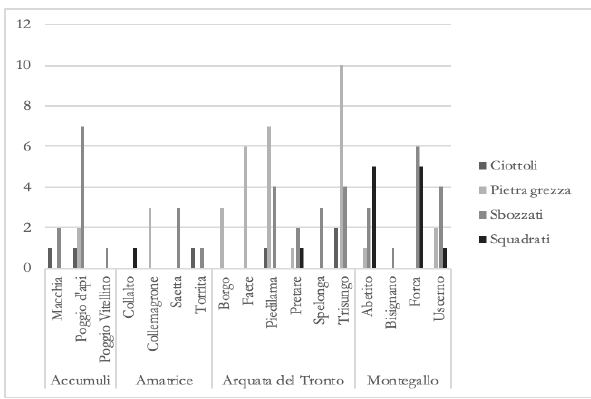
Figure 5. Relation between location and shape.